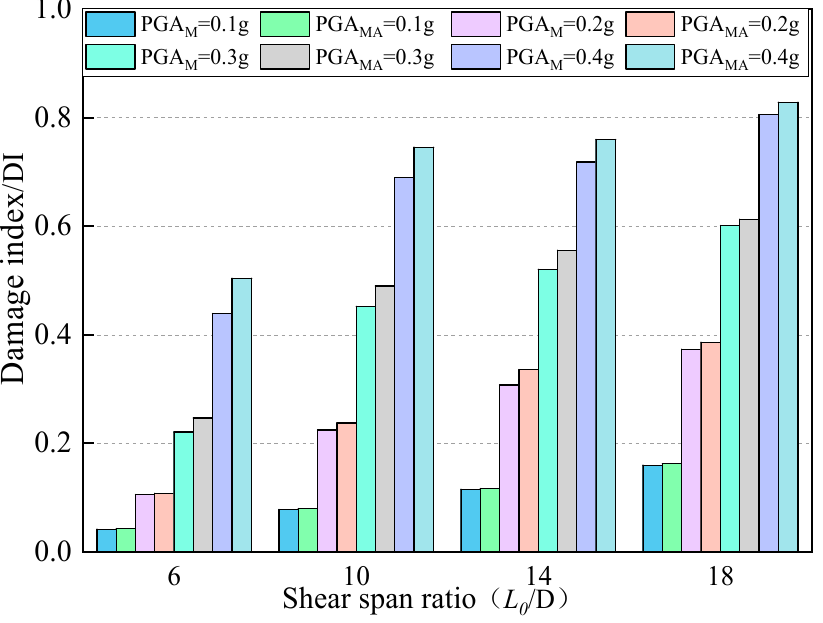
Figure 7. Damage index of the column. Table 5. The columns damage growth rate (%).